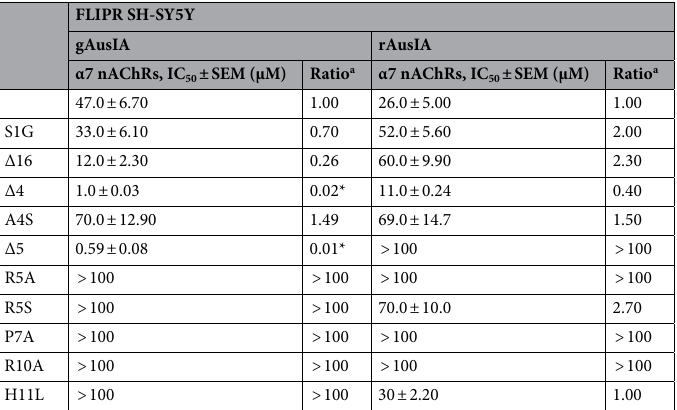
Table 1. The IC 50 for the inhibition of choline activation of α7-containing nAChRs in SH-SY5Y cells by AusIA and analogues. *Denotes significant change in IC 50 compared to wildtype. a IC 50 ratio was calculated between gAusIA/rAusIA and its corresponding